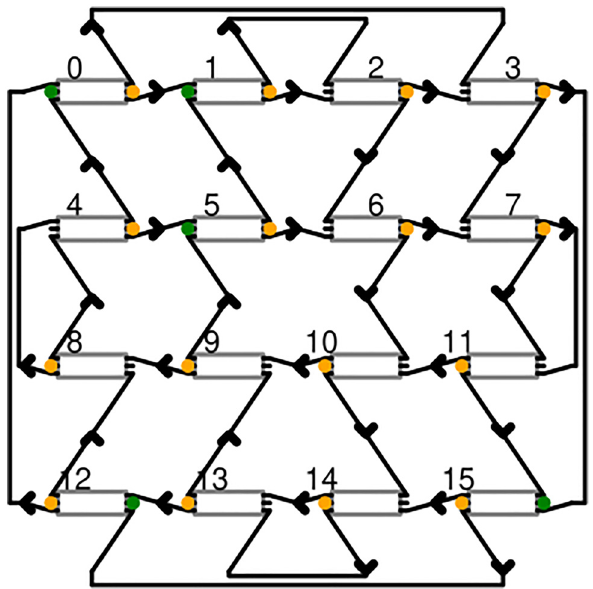
Figure 2: Schematic of the photonic 4-port reservoir. Grey boxes indicate 3 × 3 MMIs, green ports indicate the subset of input injection locations which are to be investigated, and orange dots are where output ports connect to the trainable readout weights. MMIs are connected by waveguides as shown by the black